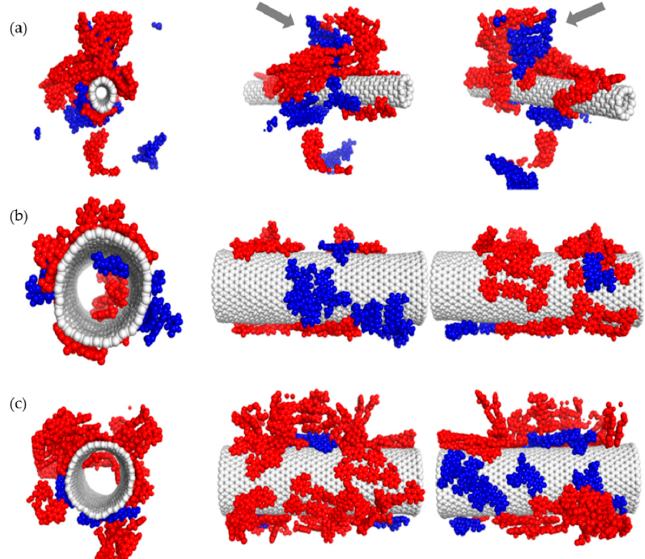
Figure 5. The structure of SWNT-CR-DOX systems at neutral pH values. ( a ) system composed of SWNT (10.0), 20 CR molecules (red) and 10 DOX molecules (blue), arrows show partial incorporation of DOX into supramolecular CR structure; ( b ) system composed of SWNT (30.0), 20 CR molecules and 10 DOX molecules; ( c ) system composed of SWNT (30.0), 40 CR molecules and 10 DOX molecules. Ionic strength of the solution was 0.145 M. Inset: scanning electron microscope photograph of nanotube (10 nm wide) with CR-DOX complex bound to the surface (concentration of CR = 1 mg/mL).